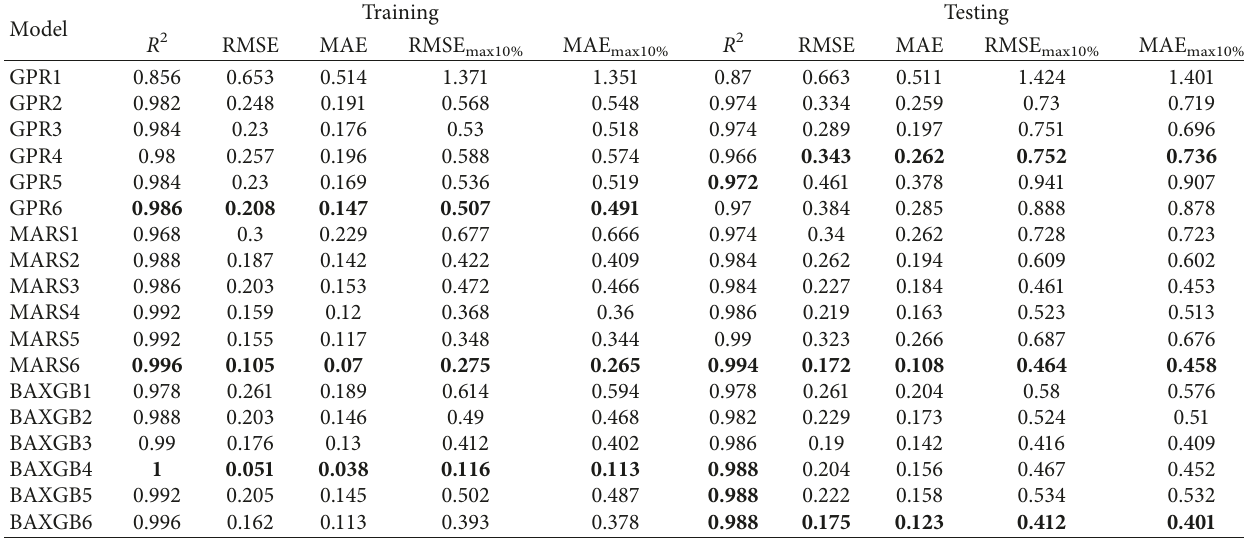
Table 5: Results of the statistical indicators for all models in the Yinchuan station during the training and testing stages. Training Testing Model